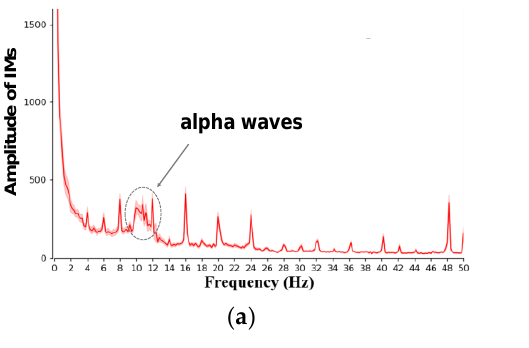
Figure 2. Amplitude spectrum and signal-to-noise ratios . ( a ) The alpha wave can be clearly observed, which may overlap with IMs in the spectrogram of the EEG signal. ( b ) The alpha wave is attenuated in the signal-to-noise ratio of the EEG signal and the IM components become clearer than before.